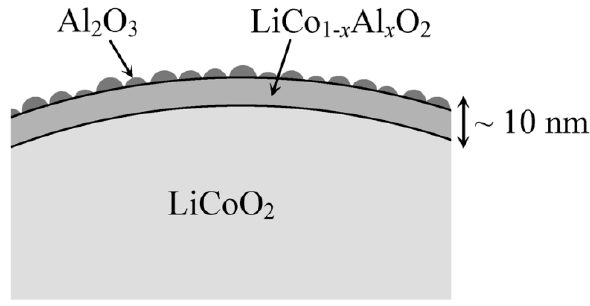
Figure 9. Schematic view of the formation of the solid solution at the coating/active material interface. Adapted with permission from [54], © American Chemical Society, 2009.